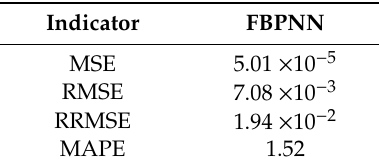
Table 1. Evaluation indicators.